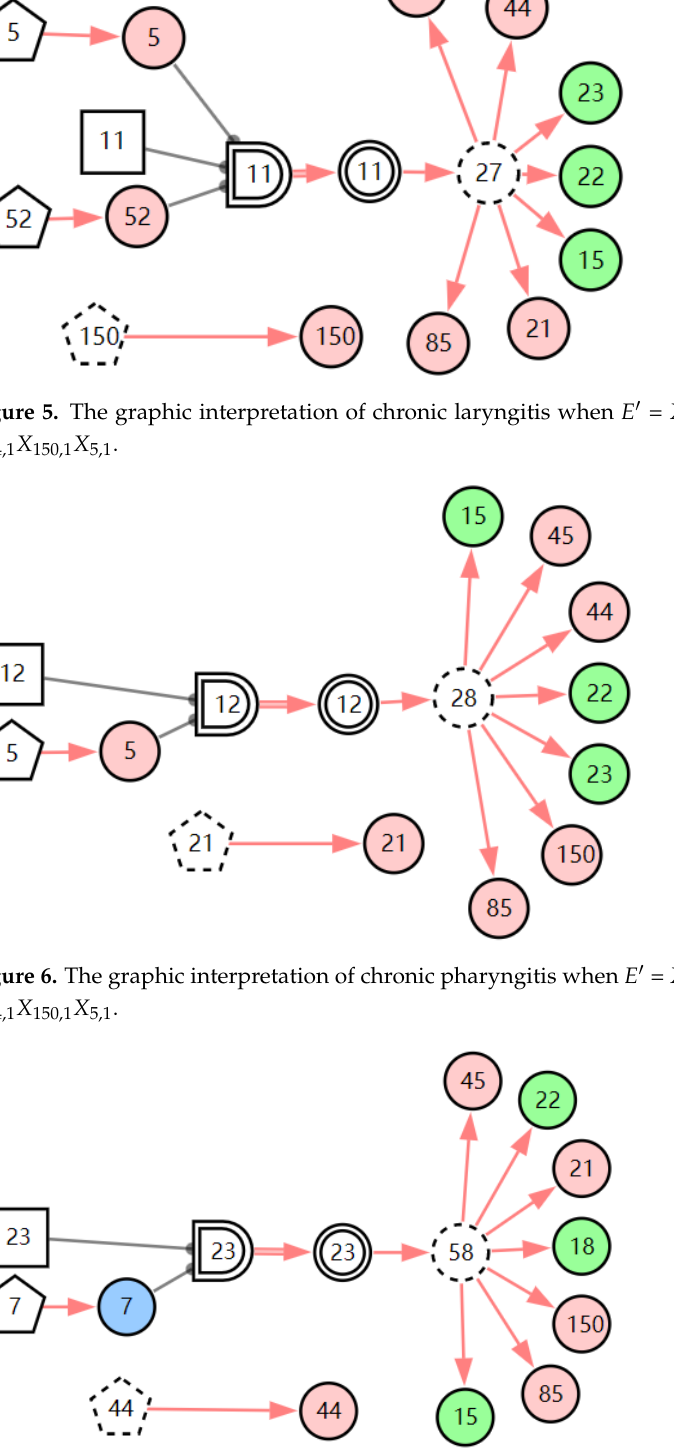
Figure 7. The graphic interpretation of LPR when E ’ = X 7,4 X 52,1 X 85,1 X 21,1 X 15,1 X 45,1 X 44,1 X 150,1 X 5,1 .